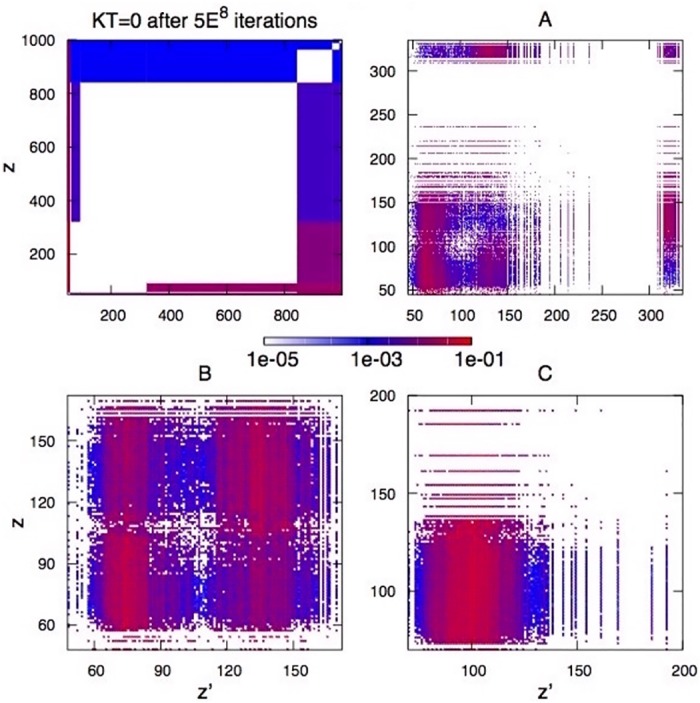
Density plots of the conditional degree distribution P(z′, z) of the graphs for insets A, B, C of Fig 7, and also in the KT = 0 case after 5 ⋅ 108 iterations, showing that in the absolute-power regime all of the most coordinated agents are principally connected to the lower class.